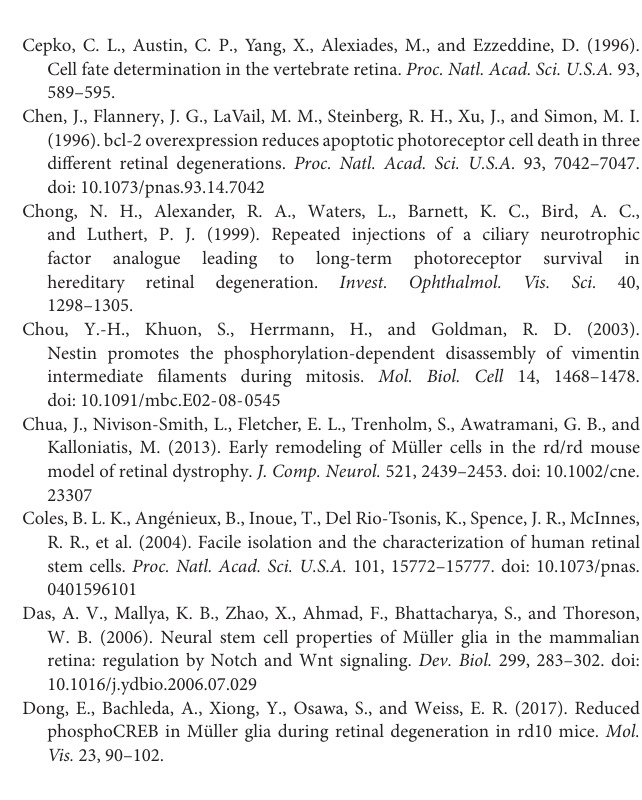
FIGURE S1 | Specificity of photoreceptors and glial markers in culture. Phase (a,f) and fluorescence (b − e,g − j) photomicrographs of wt neuronal cultures (a − e) , showing photoreceptors labeled with an anti-CRX antibody (c,h) , and of rd1 MGC cultures (f − j) , showing MGC labeled with an anti-GS antibody (b,g) . Nuclei were visualized with DAPI (d,i) . Merge images (e,j) . Scale bar: 20 µ m. FIGURE S2 | CRX-positive neurons in mixed neuron-glial cultures. Phase (a,e) and fluorescence (b − d,f − h) photomicrographs of 6-day mixed wt (a − d) and rd1 (e − h) neuron-glial cultures showing photoreceptors labeled with anti-CRX antibody (b f) . Cell nuclei were visualized with DAPI (c,g) . Merge images (d,h) . Bars in (i) represent the percentage of CRX-positive neurons (photoreceptors) at days 6 and 11 in wt and rd1 mixed neuron-glial cultures. Scale bar: 20 µ m. Statistical analysis was performed using a One-way ANOVA with a post hoc Tukey test. No significant differences were observed between